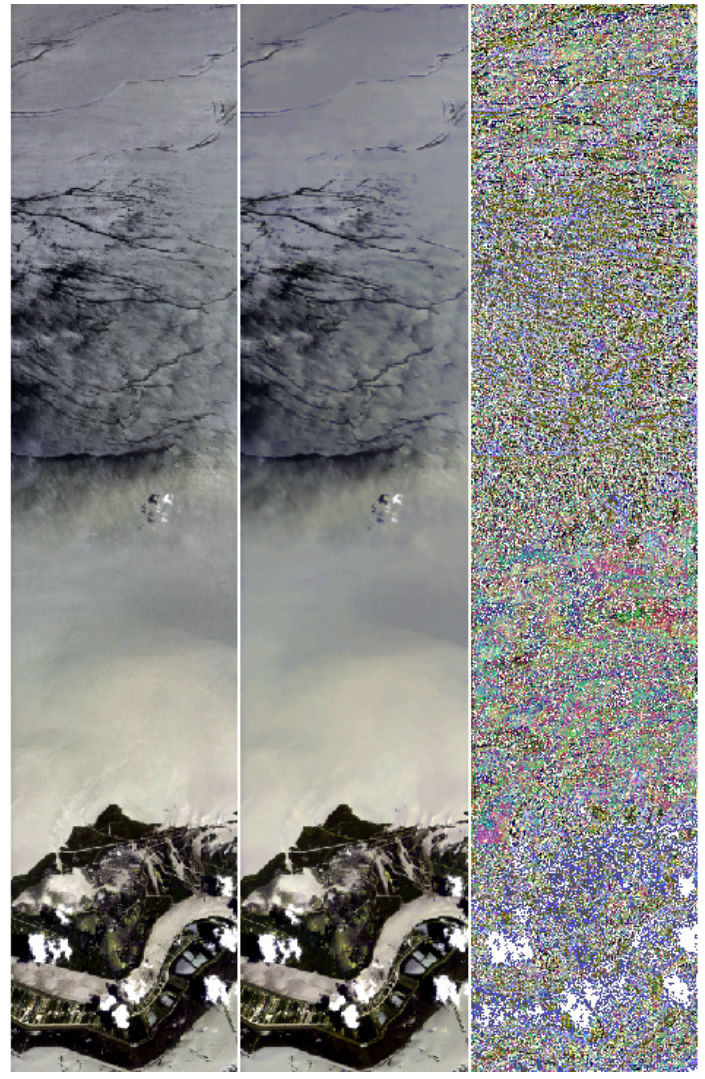
Figure 3. Original (left) and NLM denoised (middle) RGB Oil Spill image. Difference of the two images (estimated noise) is shown on the right composing the differences of the same RGB